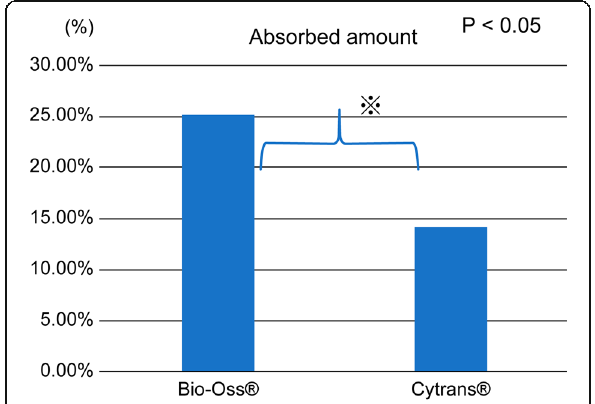
Fig. 5 Amount of resorption of Bio-Oss® and